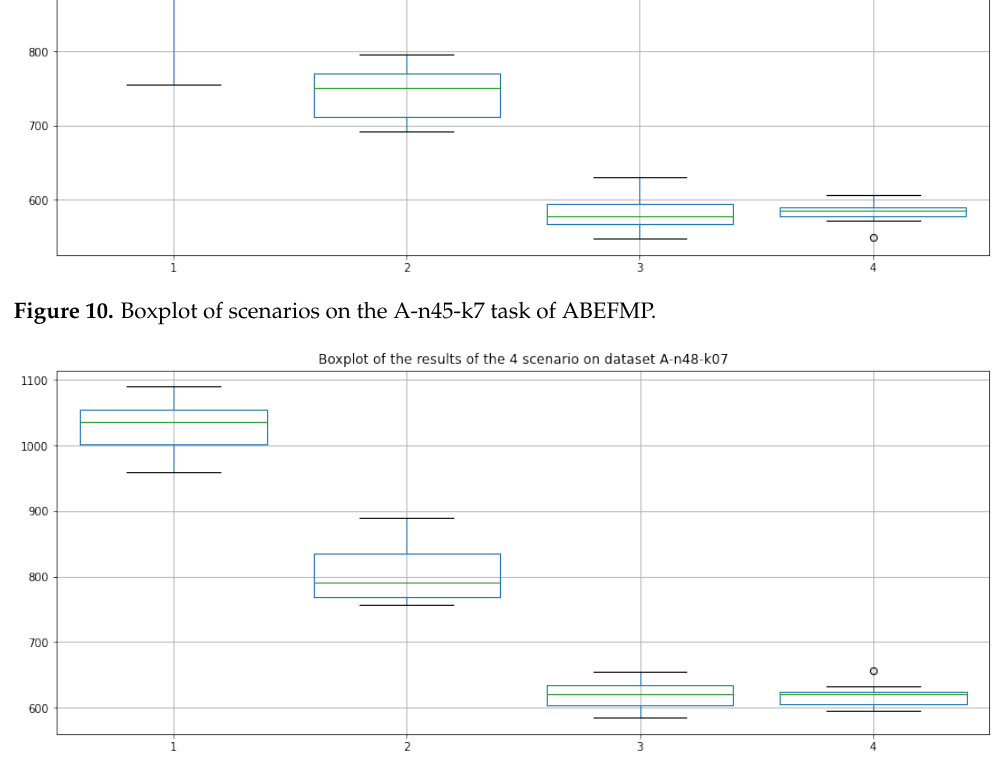
Figure 11. Boxplot of scenarios on the A-n48-k7 task of